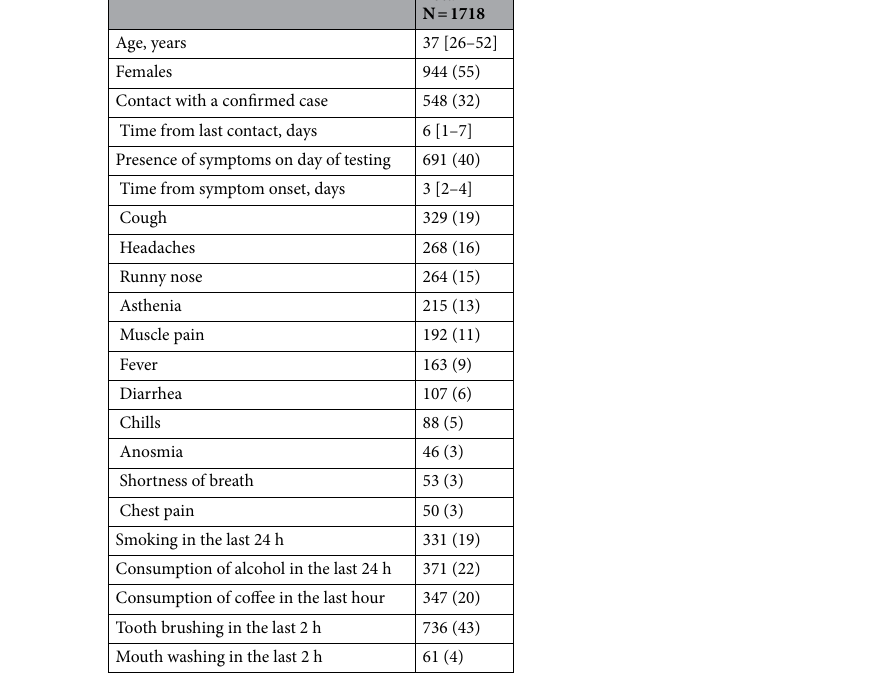
Table 1. Characteristics of study participants. Results are presented as N (%) or median [interquartile range].